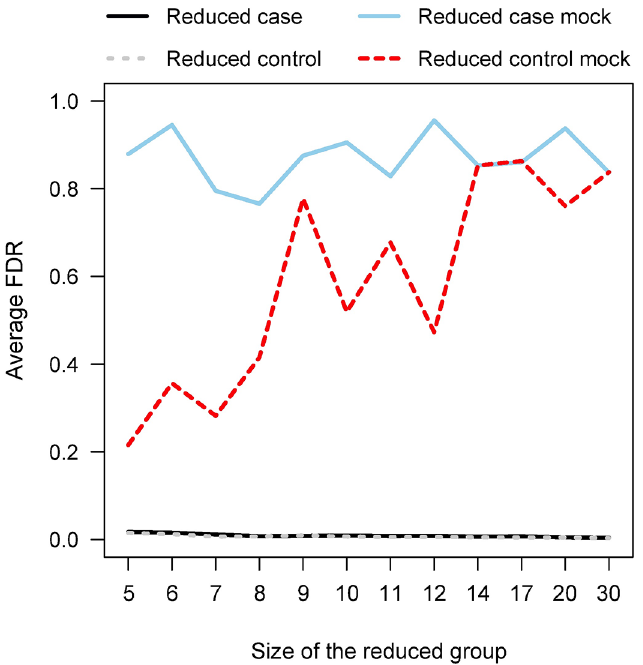
Fig 3. Sample size effect. Effect of sample size (x-axis) on the average FDR (y-axis) in data T1D_4. The black solid line illustrates average FDR when all control samples were used, but case samples were limited to a randomly selected subset (x-axis). Similarly, the gray dotted line illustrates average FDR when all case samples were used, but number of control samples was reduced. The blue solid line and the red dashed line describe the average FDR in mock data when the number of case or control samples were reduced, respectively. High FDR is expected from mock data as there is no difference between the test groups. Ten random subsets of samples for each sample size were used to obtain the average FDR